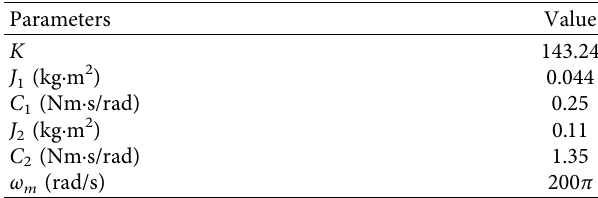
Table 2: Value of the parameters of